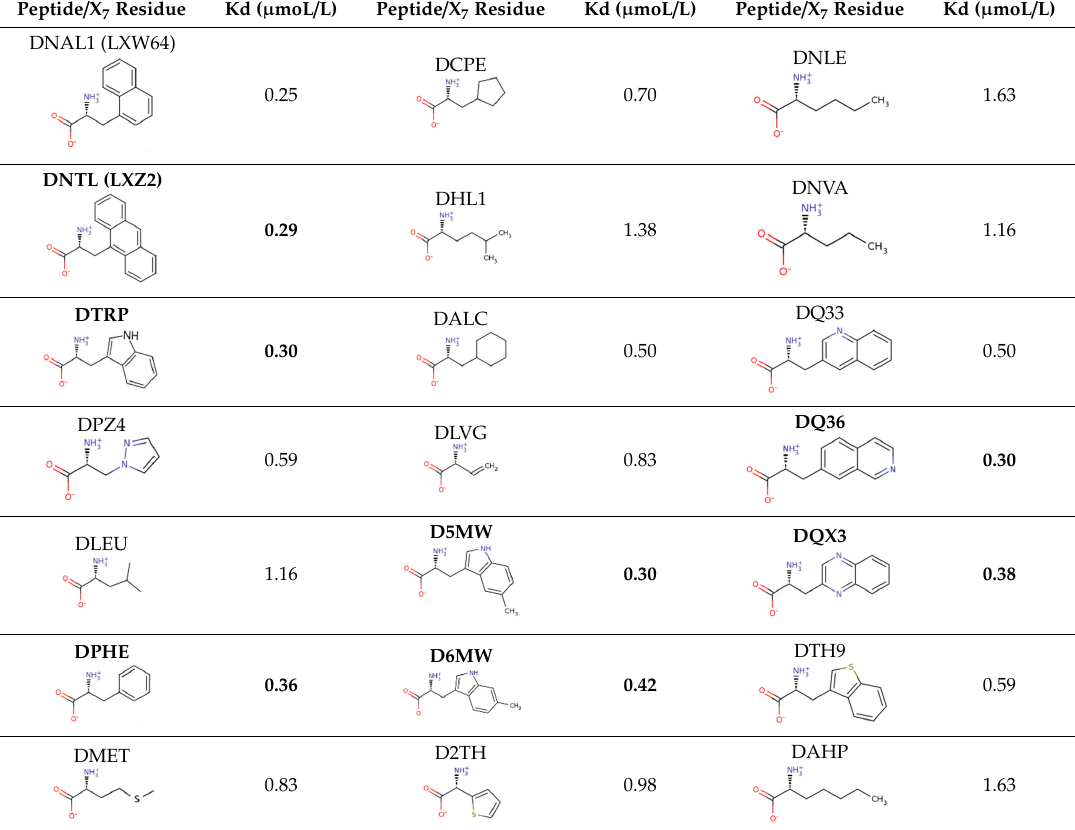
4. X7 amino acids screened from the SwissSidechain database 4. 20 X7 amino acids screened from the SwissSidechain database 4. 20 X7 amino acids screened from the SwissSidechain database (https://www.swisssidechain.ch/) in LXW-analogous cyclic octapeptides (cGRGDd X c-NH 2 ) and the (https://www.swisssidechain.ch/) in LXW-analogous cyclic octapeptides (cGRGDd X c-NH 2 ) and the (https://www.swisssidechain.ch/) in LXW-analogous cyclic octapeptides (cGRGDd X c-NH 2 ) and the peptides’ binding affinities (Kd, µmoL/L) to α v β 3 integrin calculated by Autodock 4.2. (note: Residues peptides’ binding affinities (Kd, µmoL/L) to α v β 3 integrin calculated by Autodock 4.2. (note: Residues peptides’ binding affinities (Kd, µmoL/L) to α v β 3 integrin calculated by Autodock 4.2. (note: Residues highlighted in bold are comparable to LXW64 listed as a reference and all non-natural amino acid highlighted in bold are comparable to LXW64 listed as a reference and all non-natural amino acid Table 4. 20 X7 amino acids screened from the SwissSidechain database (https: // www.swisssidechain.ch / ) highlighted in bold are comparable to LXW64 listed as a reference and all non-natural amino acid codes are from the SwissSidechain database). codes are from the SwissSidechain database). in LXW-analogous cyclic octapeptides (cGRGDd X c-NH 2 ) and the peptides’ binding a ffi nities (Kd, codes are from the SwissSidechain µ moL / L) to α v β 3 integrin calculated by Autodock 4.2. (note: Residues highlighted in bold are Peptide/ Peptide/ Peptide/ comparable to LXW64 listed as a reference and all non-natural amino acid codes are from the X 7 Residue L) SwissSidechain database).